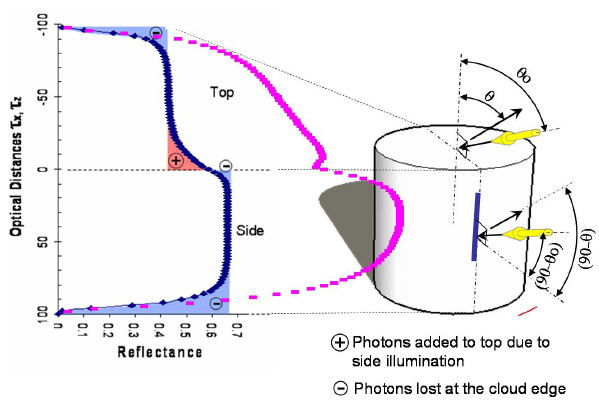
Fig. 4. Cloud side and top radiances at 2.1µm (blue) and 0.66µm (pink) calculated with the 3-D radiative transfer code SHDOM for a simplified cylindrical cloud with homogeneous r eff = 10µm wa- ter droplets, solar zenith angle θ o = 60 ◦ , and view zenith angle θ = 45 ◦ . The colored (blue and red) areas around the plot of the 2.1µm curve represent photons that have been added or lost near the cloud edges. In this particular case the top reflectance is lower than the side reflectance due to the relative angle between the so- lar illumination and a vector normal to the side or the top surfaces. The relative angle with the top surface vector is 60 ◦ whereas the angle with the side vector is 30 ◦ . The blue line along the surface of the cylinder represents the region where there is saturation and the 2.1µm reflectance from the cylinder equals the plane parallel result with the proper geometry. A point half way along the blue line represents the general place that was selected to construct our 3D-LUT from retrievals away from the cloud edges. Other regions of the cylinder could be used for retrievals closer to cloud base or